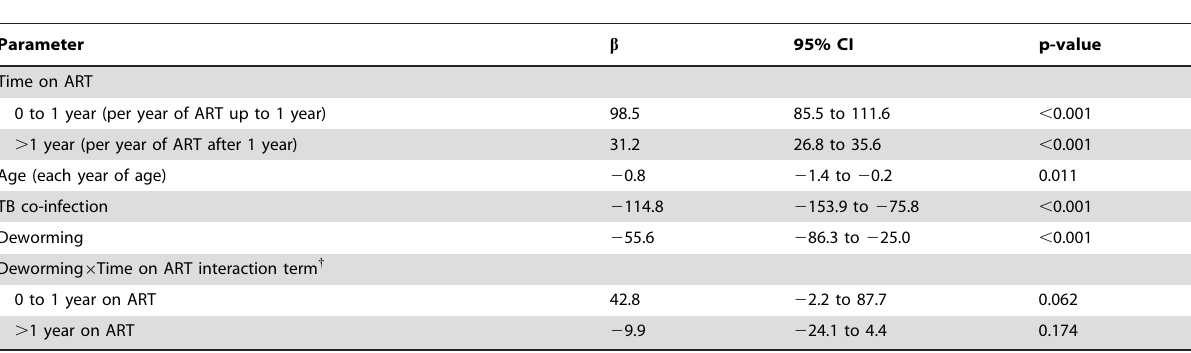
Table 2. Primary analysis: multivariable linear regression model of predictors of CD4 count